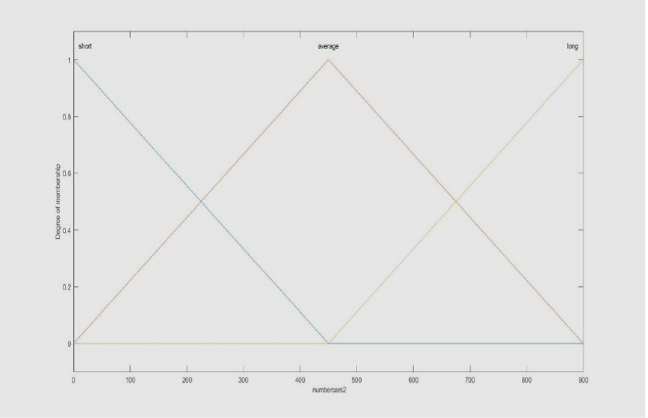
Figure 3. Second input to fuzzy controller for junction 1 with three linguistic values.